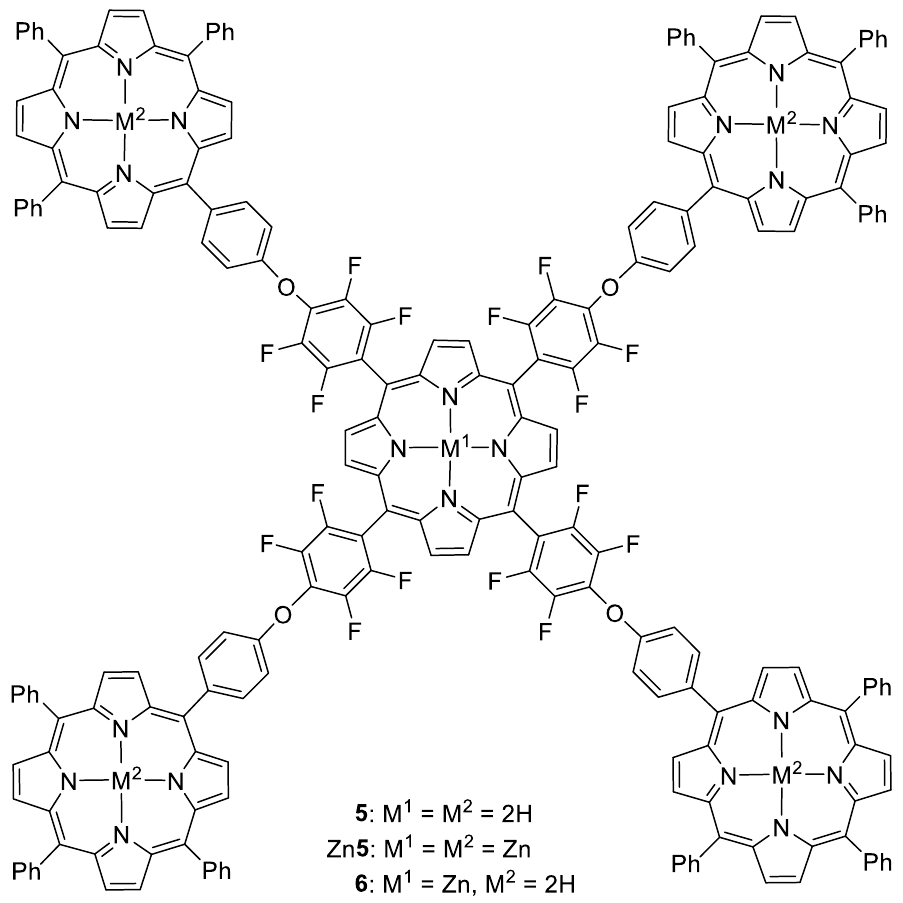
Figure 1. Molecular structures of pentaporphyrins 5 , Zn 5 and 6 .